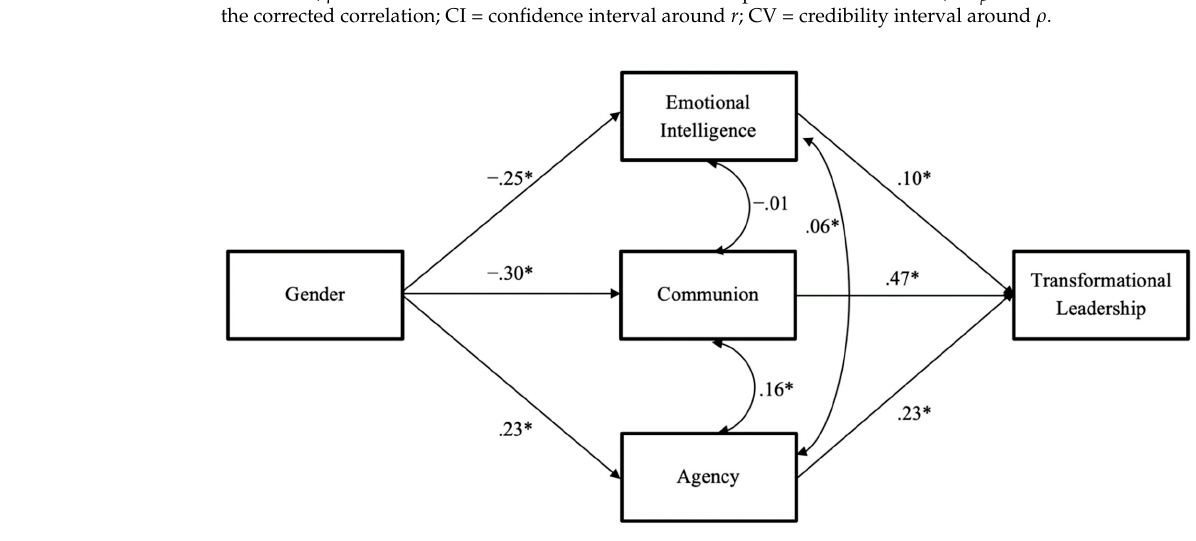
Figure 3. All hypothesized paths were statistically significant in the expected directions.